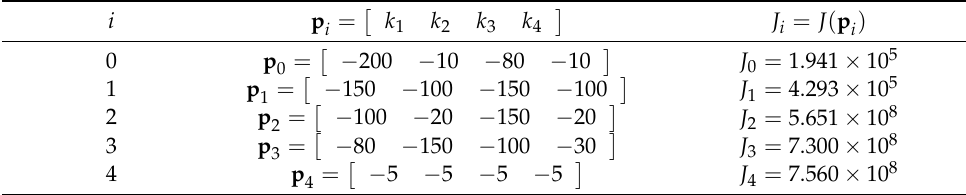
Table 2. Initial controller parameters for the inverted pendulum